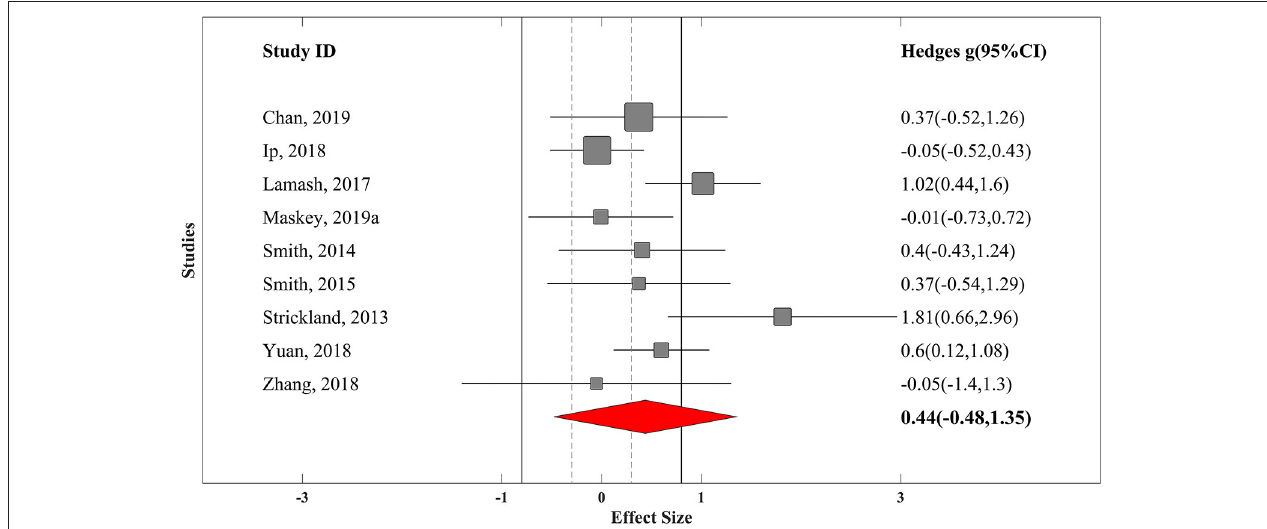
FIGURE 2 | Forest plot of overall effectiveness of VR training for controlled trials with 95% confidence interval. Solid vertical lines represent strong effect size boundary ( g 0.8 and 0.8), and dashed vertical lines represent weak effect size boundary ( g = −